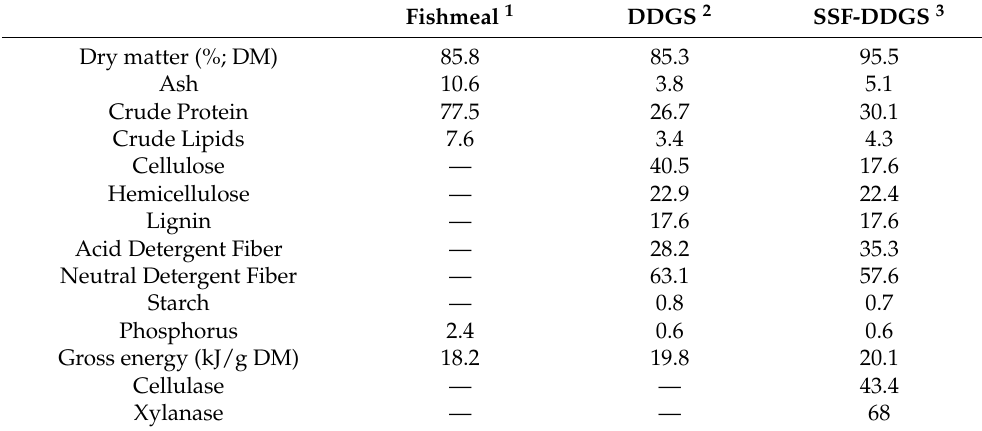
Table 1. Chemical composition (% DM) and enzymatic activity (U/g DM) of test ingredients.